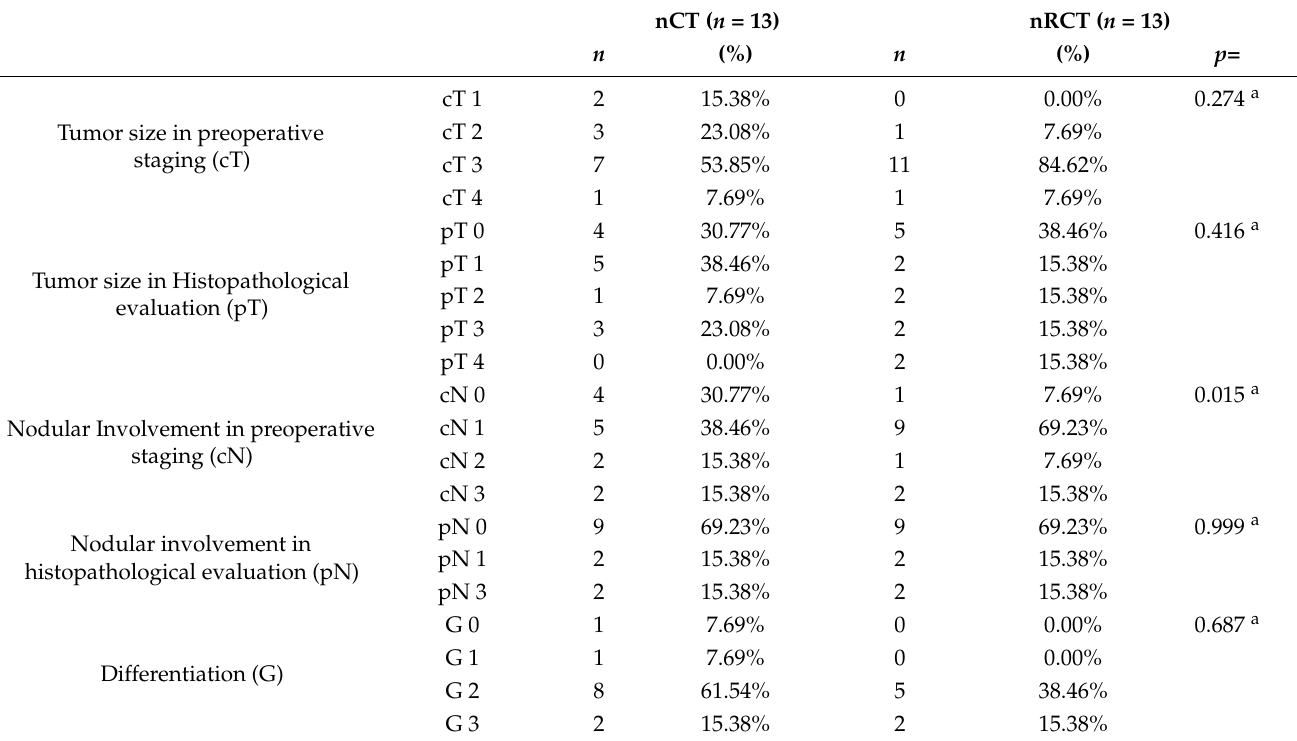
Table 2. Univariate analysis of histopathological